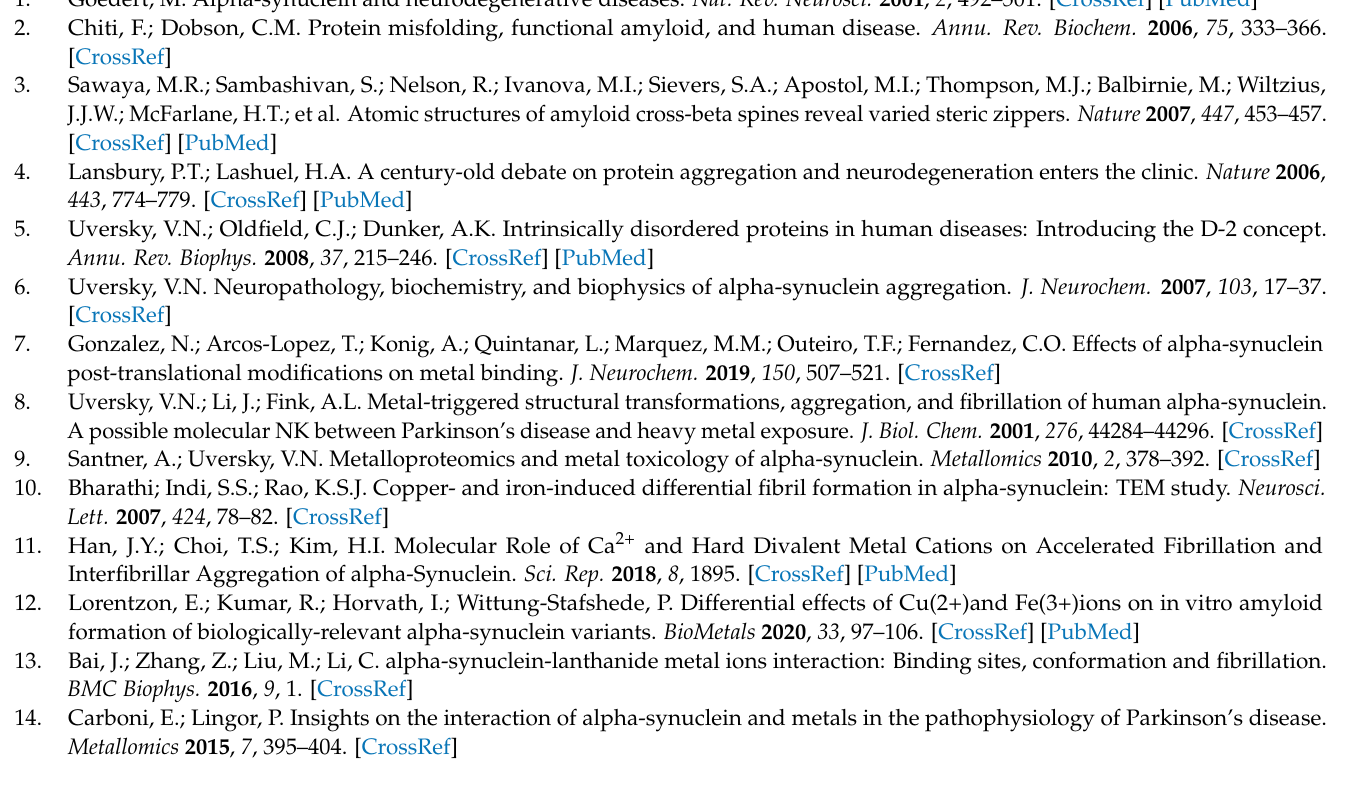
Second derivative spectrum of α -synuclein amyloid fibril under the influence of 0.4 mM Zn 2+ in the amide I region; Figure S12: Second derivative spectrum of α -synuclein amyloid fibril under the influence of 0.6 mM Zn 2+ in the amide I region; Figure S13: Second derivative spectrum of α - synuclein amyloid fibril under the influence of 0.4 mM Cu 2+ in the amide I region; Figure S14: Second derivative spectrum of α -synuclein amyloid fibril under the influence of 1.6 mM Cu 2+ in the amide I region; Figure S15: Second derivative spectrum of α -synuclein amyloid fibril under the influence of 8.0 mM Cu 2+ in the amide I region; Figure S16: The height analysis of amyloid fibrils of the pristine α -synuclein system, α -synuclein+Fe 3+ system, α -synuclein+Zn 2+ system, and α -synuclein+Cu 2+ system; Table S1: The proportion increase of β -sheet secondary structure in α -synuclein amyloid fibril due to the influences of different concentrations of Fe 3+ ; Table S2: The proportion increase of β -sheet secondary structure in α -synuclein amyloid fibril due to the influences of different concentrations of Zn 2+ ; Table S3: The proportion increase of β -sheet secondary structure in α -synuclein amyloid fibril due to the influences of different concentrations of Cu 2+